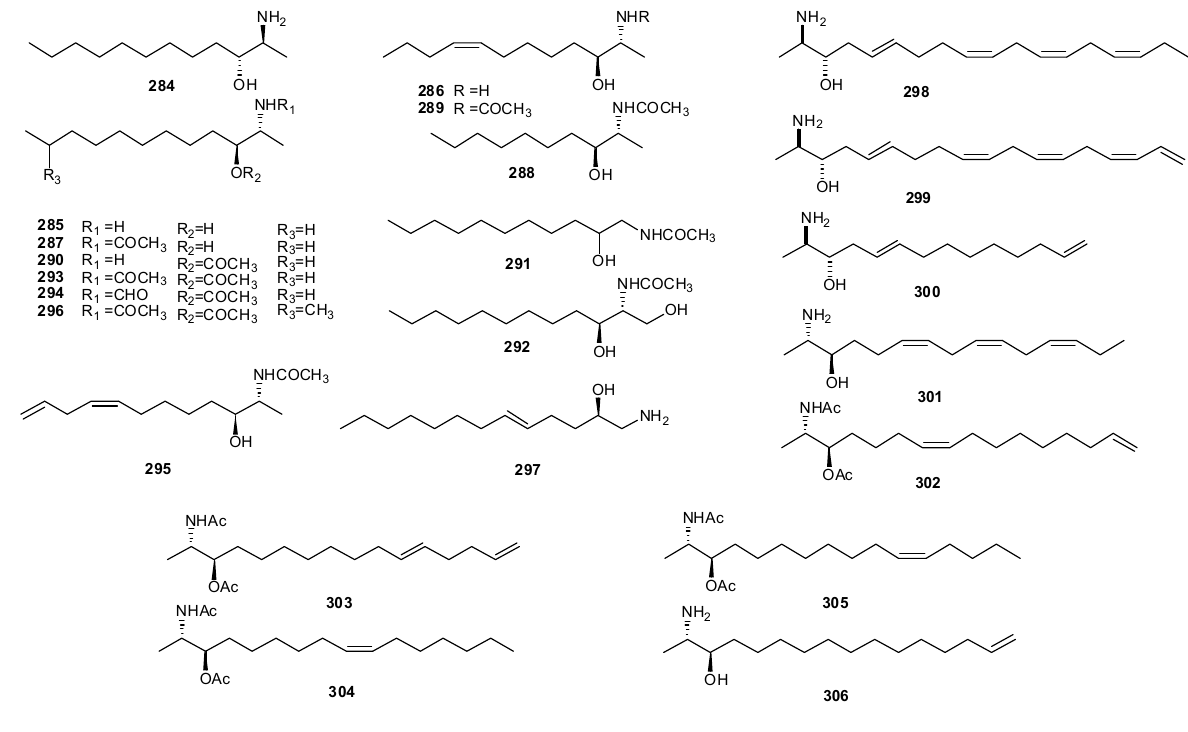
Figure 30. Structures of linear